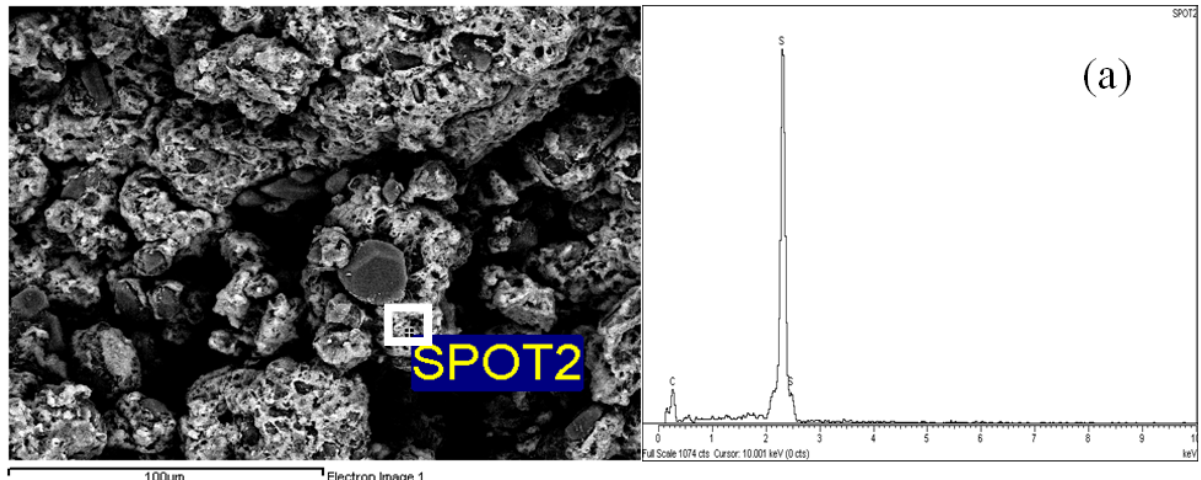
Figure 4. SEM-EDX maps showing the actual positions of the distributions of ( a ) sulphur and ( b ) carbon in polymer